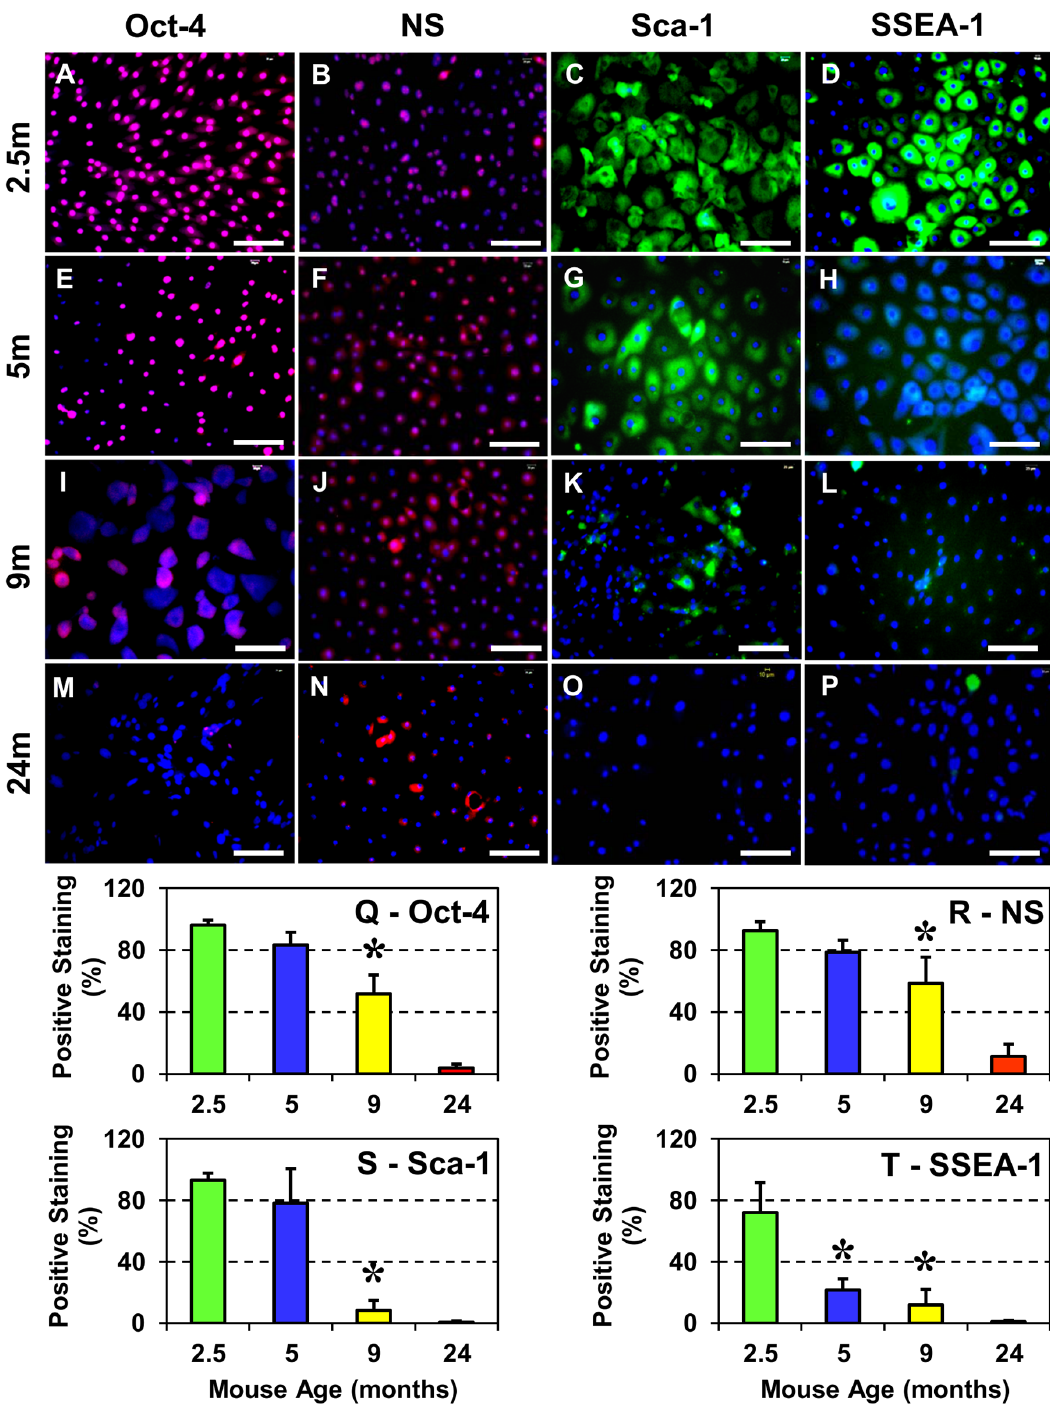
Fig 2. Stem cell marker expression in TSCs from differently aged mice (2.5m – 2.5 months; 5m – 5 months; 9m – 9 months and 24m – 24 months). A – P: Immunocytochemical staining for the indicated stem cell markers was performed using stem cell marker specific antibodies. Q – T: Semi-quantitation of stem cell marker expression after immunocytochemical staining. Increase in the mouse age decreased the number of TSCs expressing Oct-4, NS, Sca-1, and SSEA-1. In 24 months old mice, except for a few NS-expressing TSCs, expression of the remaining three stem cell markers (Oct-4, Sca-1 and SSEA-1) was very low. Semi-quantitation data are expressed as mean ± SD. Student ’ s t -test was used to determine statistical significance ( * P < 0.05) in comparison with data from the 2.5-months old mice. Bar — 100 μ m.